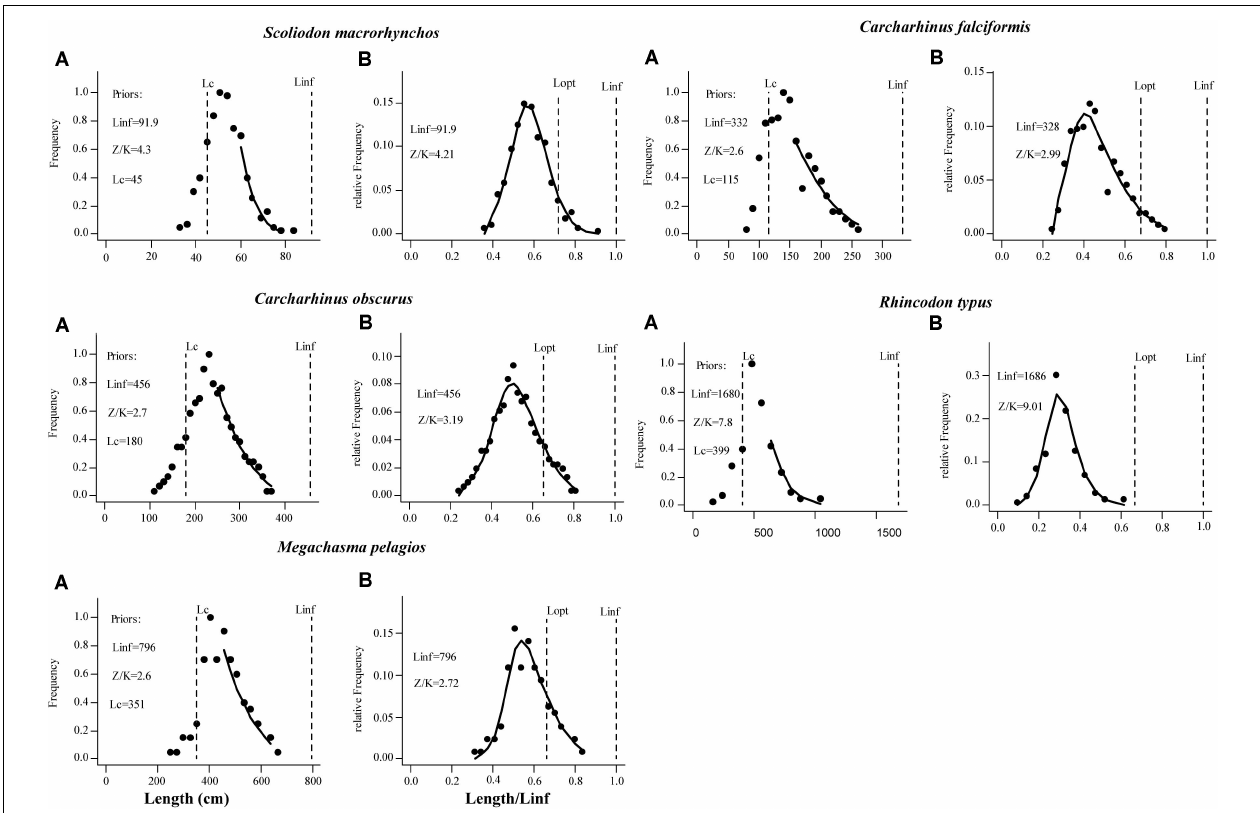
FIGURE 1 | Graphical output produced by LBB for the five species. Panels (A) show the accumulated length frequency (LF) data used to estimate priors for L inf , Z/K and L c . Panels (B) show L inf , Z/K and L opt estimated by the fitting curve. L inf is asymptotic length, Z is the total mortality, K is somatic growth rate from the von Bertalanffy growth equation, L c is the length at first capture, L opt is the length in the unfished population.